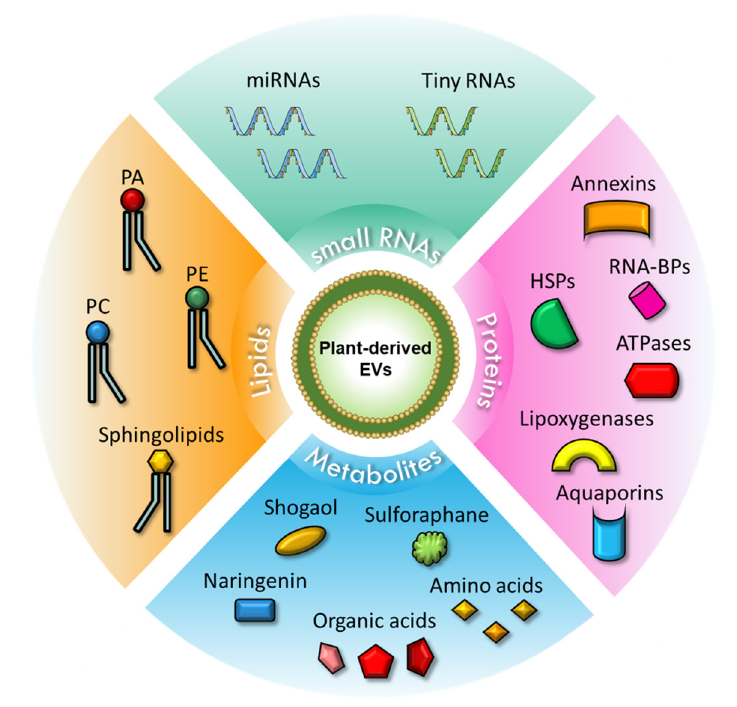
Figure 1. Schematic representation of PDEVs content. Upper corner: Small RNAs contained in PDEVs, which include miRNAs and tiny RNAs. Right corner: Proteins carried in PDEVs, including annexins, RNA-BPs, HSPs, ATPases, lipoxygenases, and aquaporins. Lower corner: Metabolites present in PDEVs, such as shogaol, sulforaphane, naringenin, organic acids, and amino acids. Left corner: Lipids found in PDEVs include PA, PE, PC, and sphingolipids. Abbreviations: miRNAs, microRNAs; HSPs, heat shock proteins; RNA-BPs, RNA binding proteins; PA, phosphatidic acid; PE, phosphatidylethanolamine; PC, phosphatidylcholine.